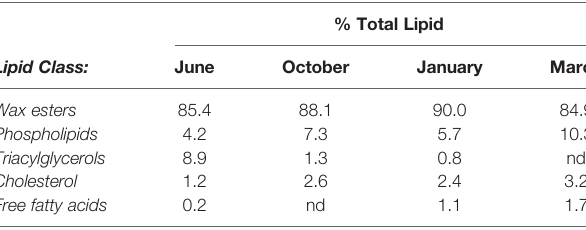
TABLE 1 | Lipid class composition of C. fi nmarchicus sampled in summer, autumn, winter, and spring in Balsfjord, Norway. % Total Lipid